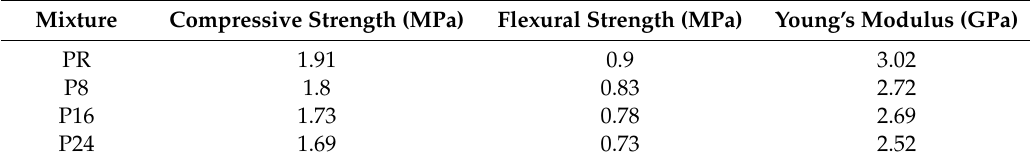
Table 3. Mechanical properties of studied plasters with FSPCM.